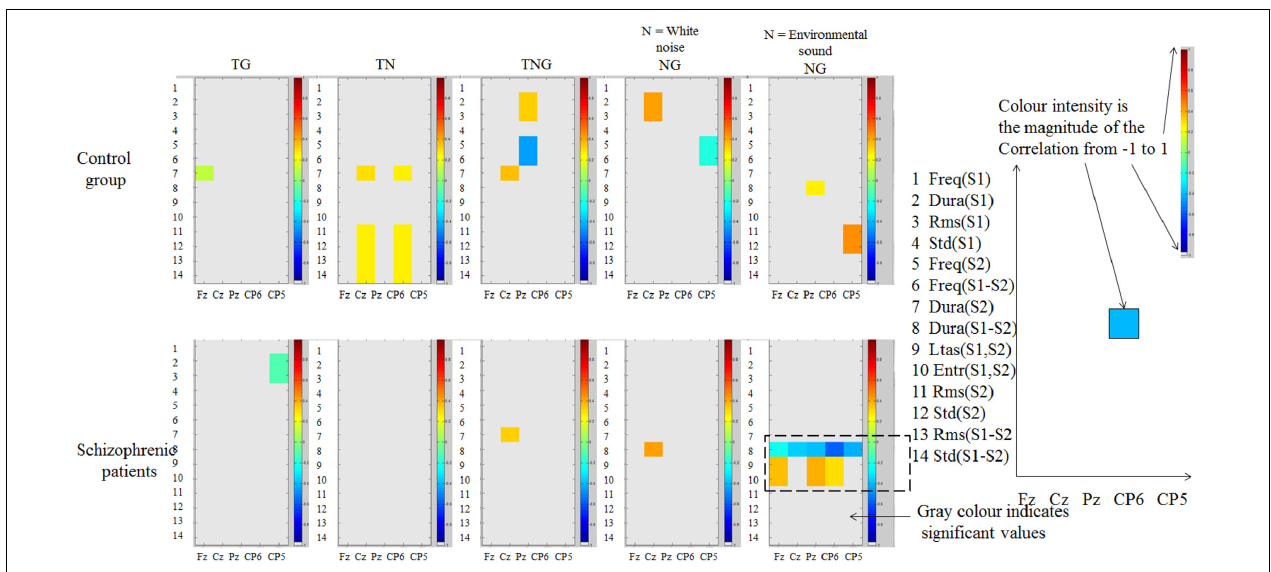
FIGURE 7 | Correlations in control participants and schizophrenic patients (shown in color) between amplitude of single trial across-subject P300 peak at channels Fz, Cz, Pz, CP6, and CP5 (horizontal axis) and 14 sound properties (vertical axis). P300 amplitude measured in the time range [250 450] ms. Difference of duration and spectrum calculations (LTAS and entropy) showed correlations across electrodes in the analysis only in schizophrenic